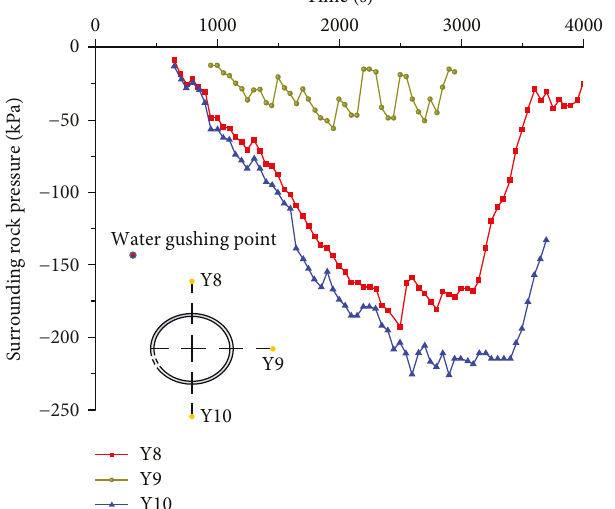
Figure 13: Surrounding rock pressure – time curves of Y8, Y9, and Y10.